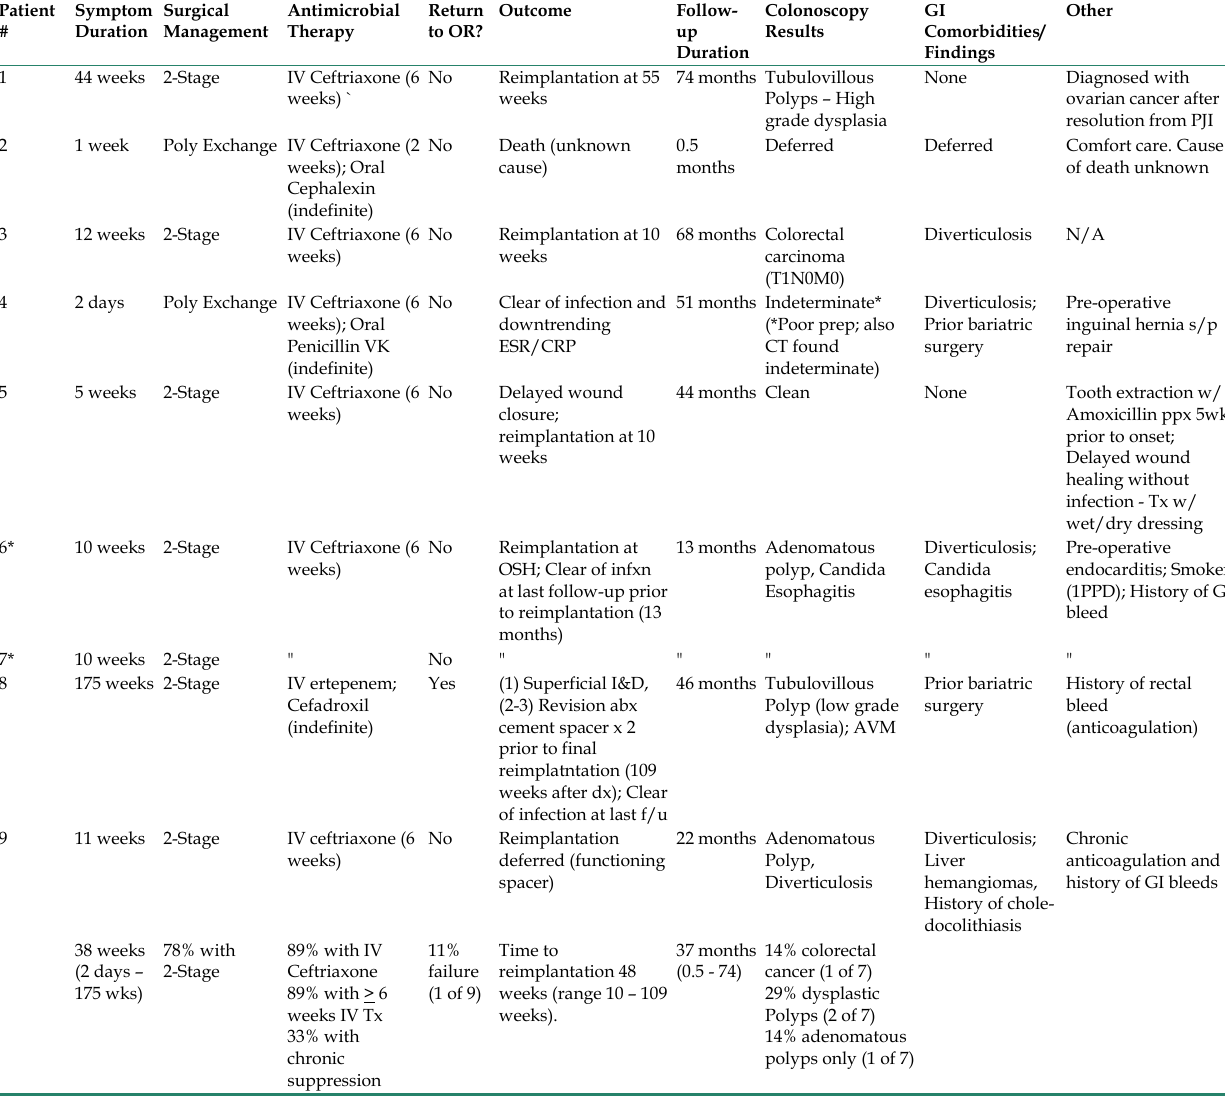
Table 2. Treatment Outcomes, Colonoscopy data, and GI mucosal risk factors related to SBG PJI in the current cohort. Patient Symptom Surgical Antimicrobial # Duration Management